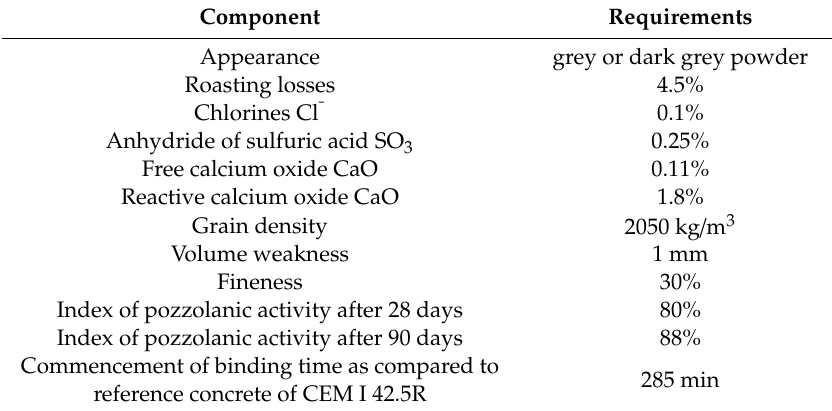
Table 4. Physicochemical composition of fly ash type